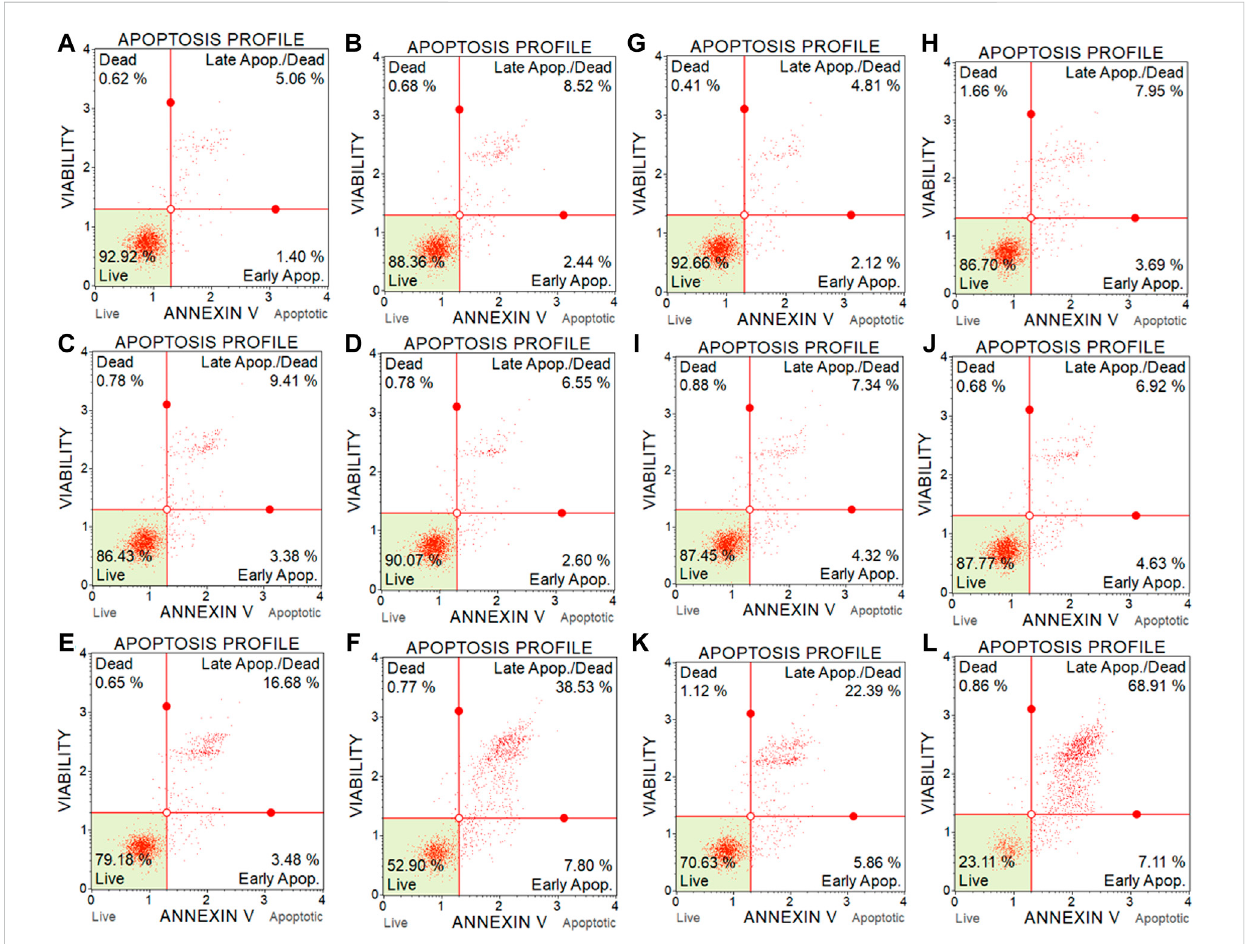
FIGURE 11 Representative fl ow cytometry scatter diagrams of HT-29 cell apoptosis after 48 h (A – F) and 72 h (G – L) incubation with medium (A and G) , with empty BC (B and H) , BC-0.25%EAE (C and I) , BC-0.5%EAE (D and J) , BC-1%EAE (E and K) , BC-2.5% EAE (F and L)